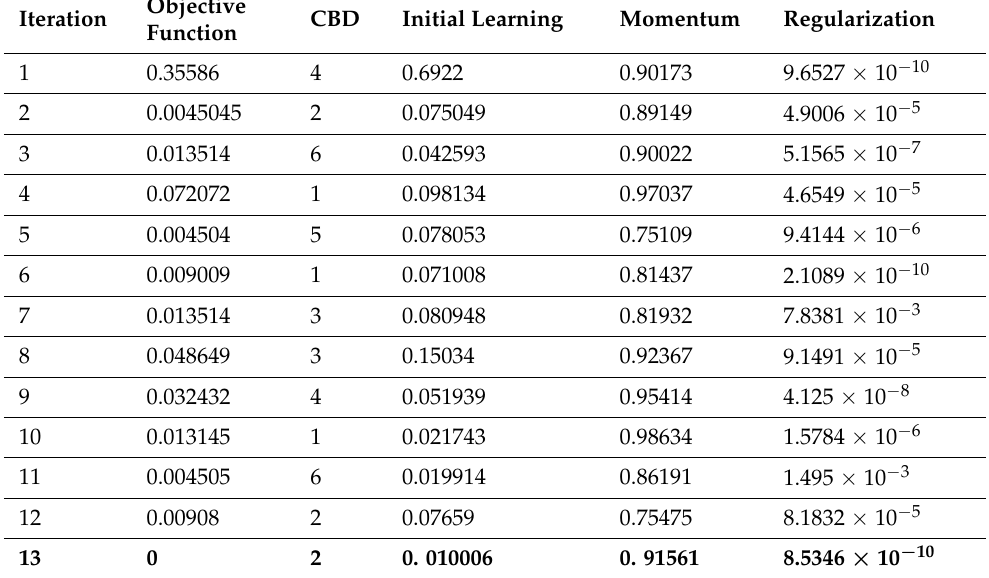
Table 2. Objective function records and corresponding hyperparameters estimates of the proposed CNN during the optimization iterations. Optimal model entries are presented in bold